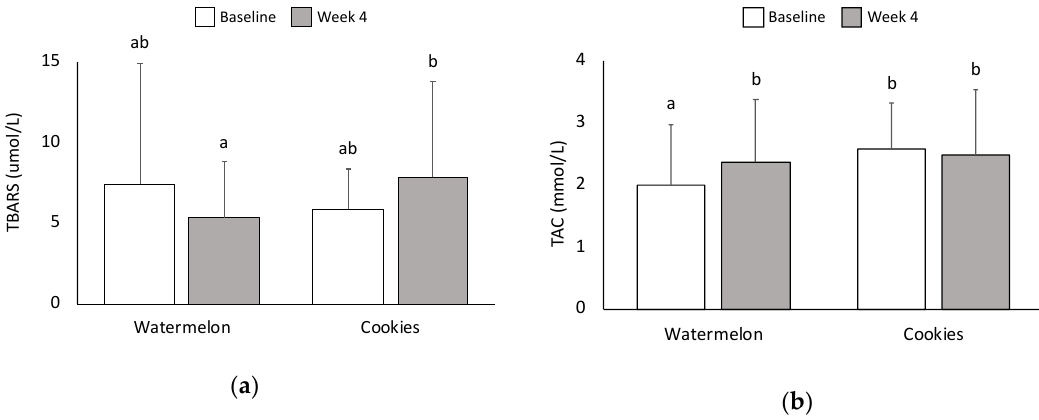
Figure 4. Effects of WM and LFC on serum values for ( a ) thiobarbituric acid reactive substances (TBARS) and ( b ) total antioxidant capacity (TAC) at baseline and week 4 of each intervention. Data are presented as means ± SD. Within a variable, values not sharing a common superscript are significantly different at p < 0.05.